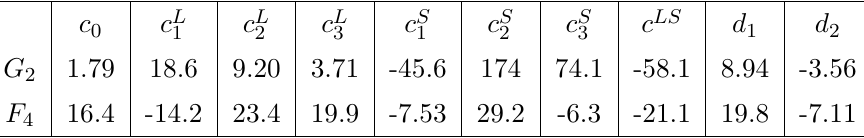
Table 3. Coefficients in eq. (3.12) for G 2 and F 4 best-fit